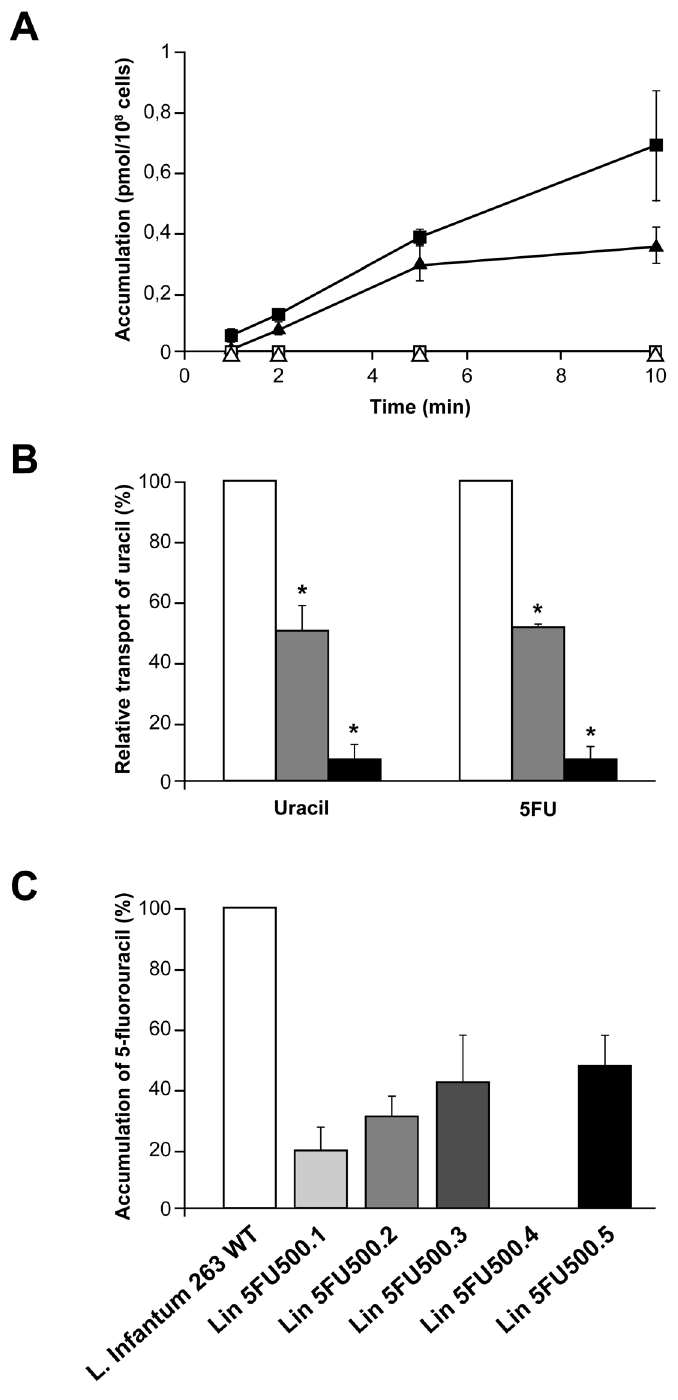
Figure 4. Transport activities of uracil and 5-fluorouracil in L.infantum wild-type cells and 5-FU resistant mutants. ( A ). Transport of 5- fluorouracil (black squares) and uracil (black triangles) in L. infantum WT cells and in Lin5FU500.4 mutant cells (5-fluorouracil (white squares) and uracil (white triangles)) after 1, 2, 5 and 10 minutes ( B ). Transport of [ 3 H]-uracil (white bars) competed with 200 6 (grey bars) or 2000 6 ratio (black bars) of cold uracil (left panel) or 5-FU (right panel) after a 10 minutes incubation period. ( C ). Accumulation of [ 3 H]-5-fluorouracil in L. infantum WT 263 strain and in the 5-FU mutants after 10 minutes. Average of three independent biological replicates. * (p , 0.05).